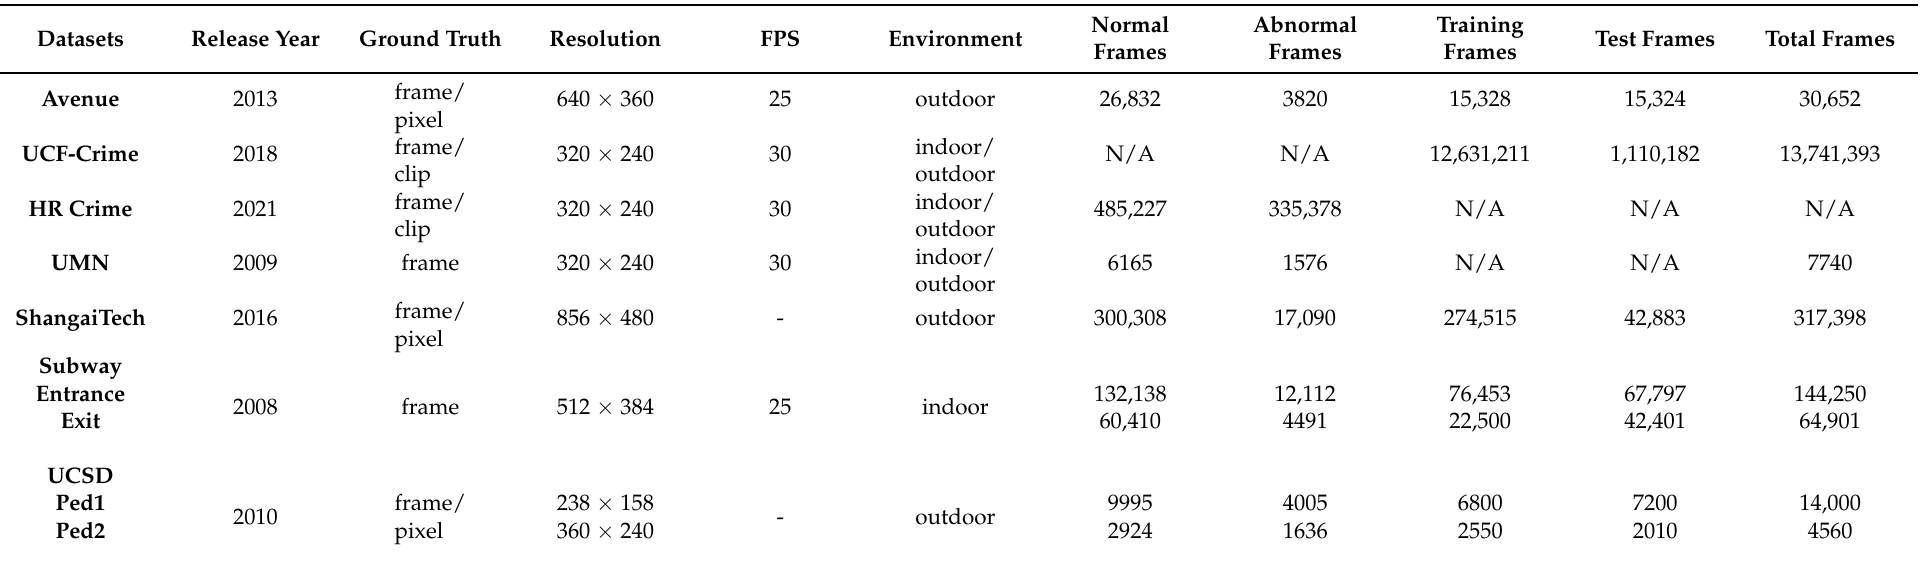
Table 10. Comparison of existing SVAD